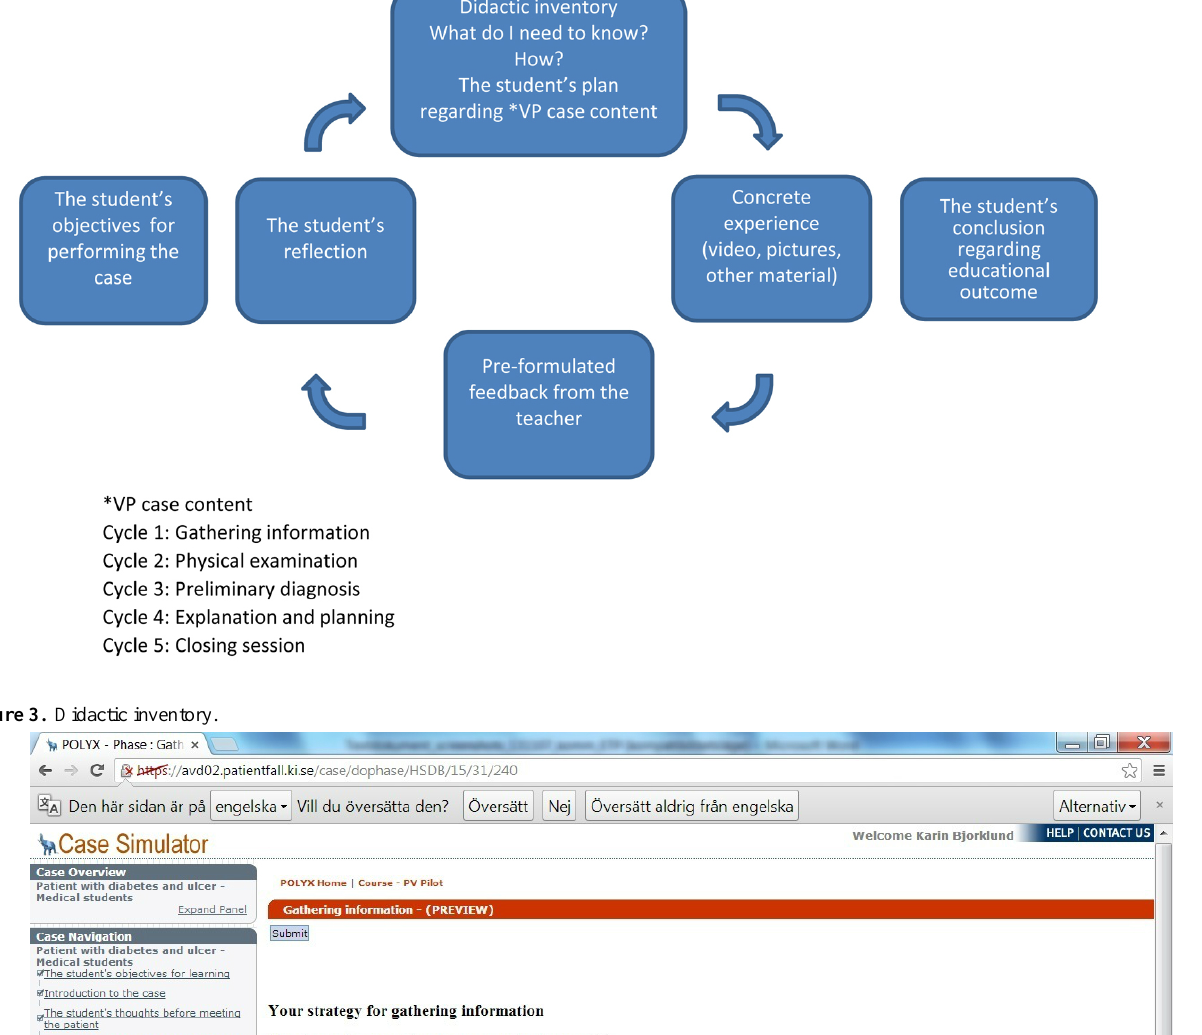
Figure 2. Iterated learning cycle (before the first cycle of the VP case started, the student formulated their objectives for performing the case; after finishing the last cycle, the student wrote a final reflection about their educational outcomes during the VP encounter).